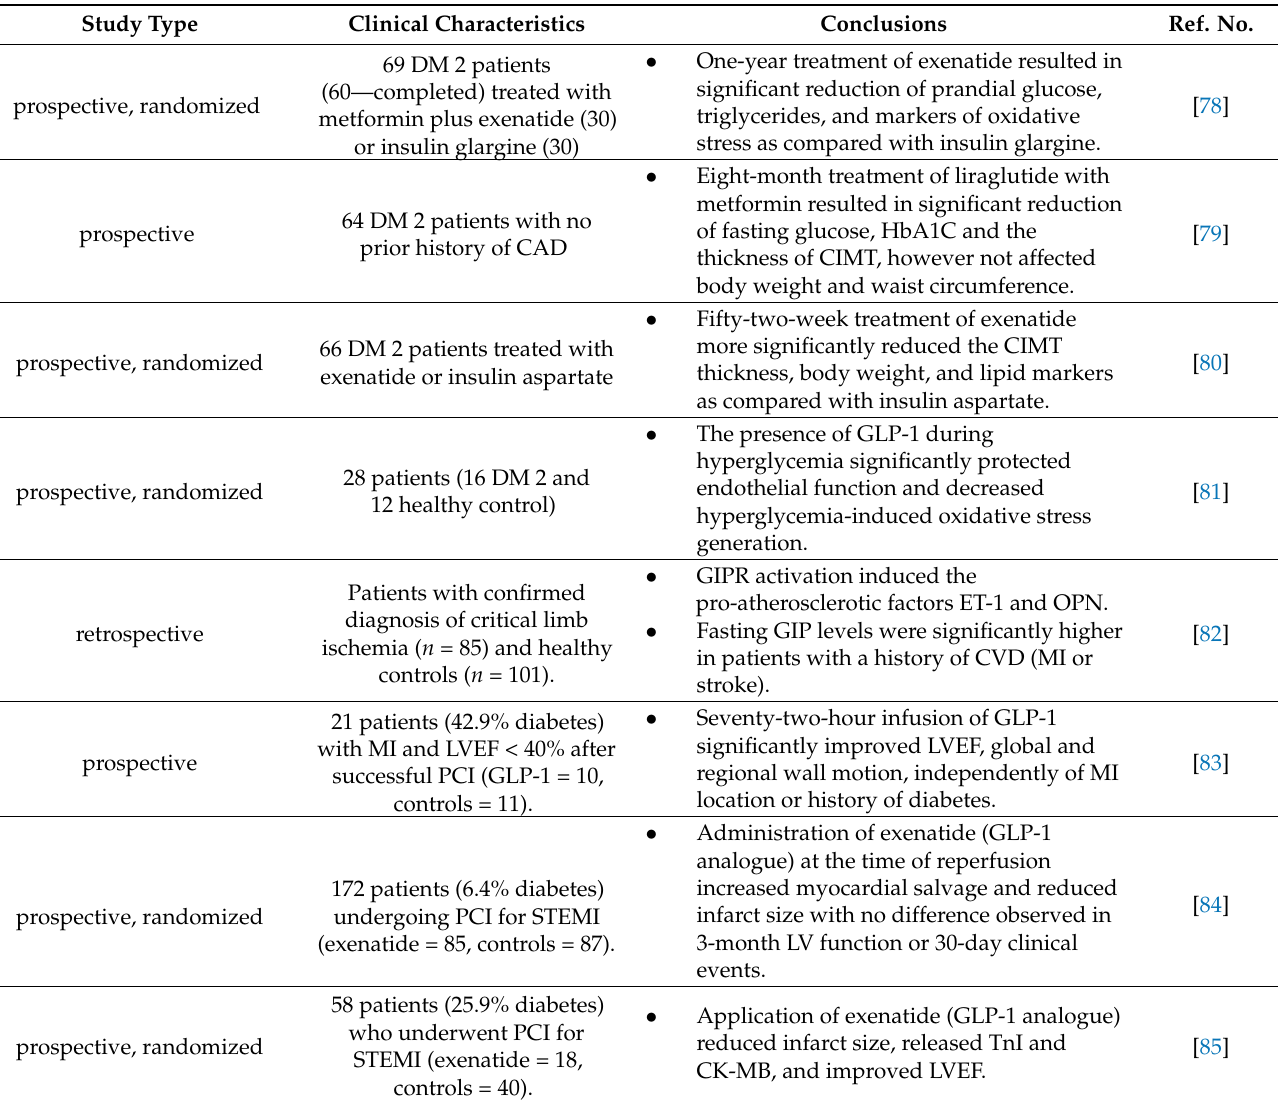
Table 2. Human studies involving the role of GIP and GLP-1 in atherosclerosis and coronary